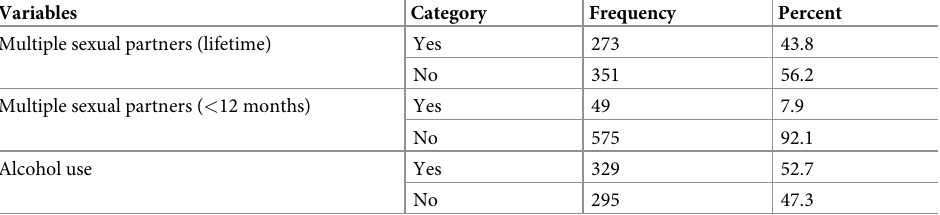
Table 3. Behavior related characteristics of study participants in Jinka town public health facilities, Southern Ethiopia,